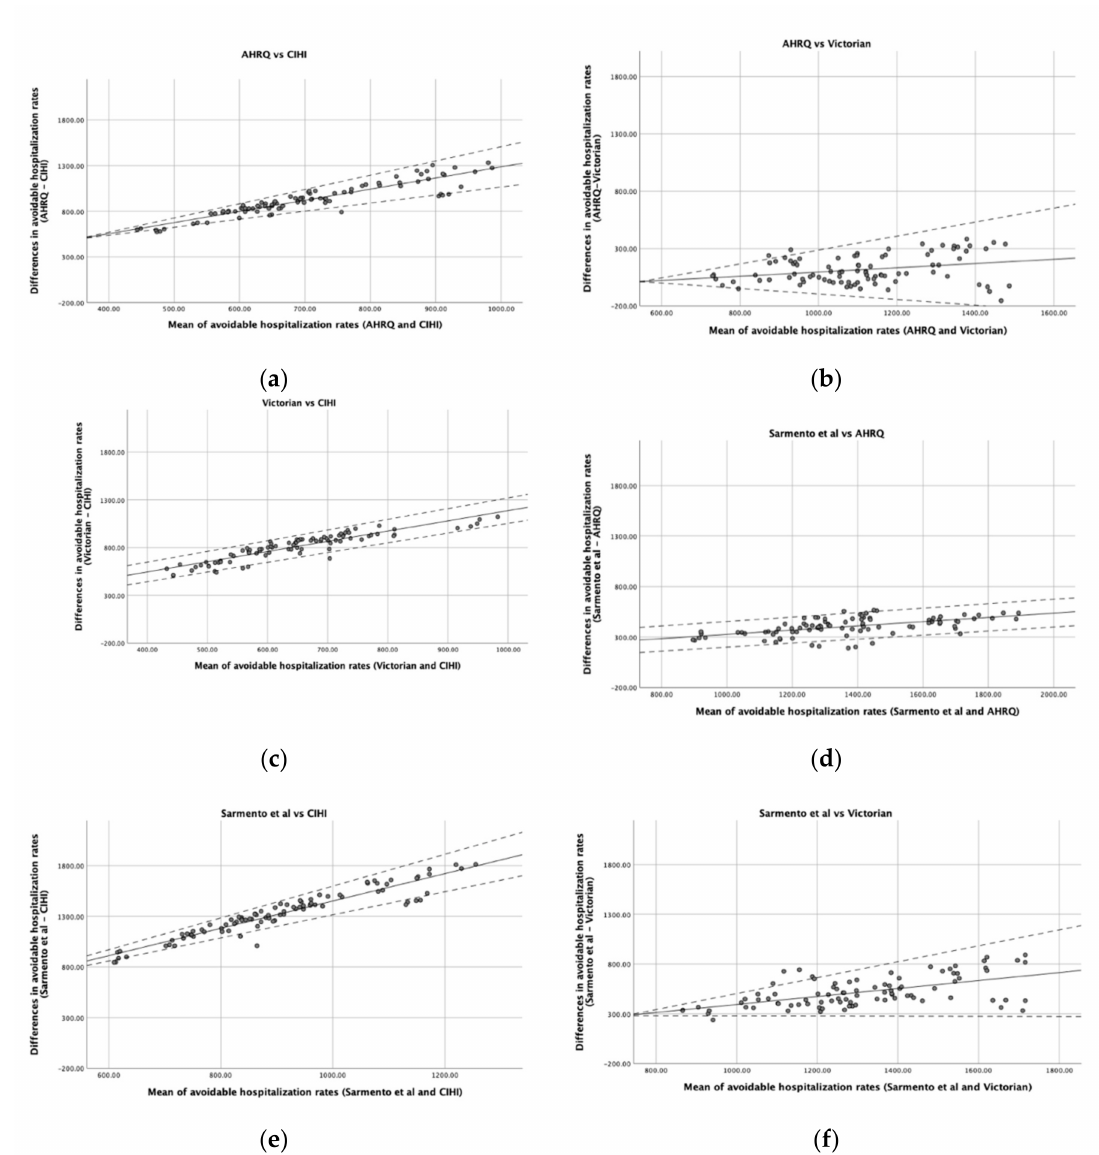
Figure 1. Bland and Altman plots comparing the agreement of di ff erent lists. ( a ) AHRQ vs. CIHI; ( b ) AHRQ vs. Victorian; ( c ) Victorian vs. CIHI; ( d ) Sarmento et al. vs. AHRQ; ( e ) Sarmento et al. vs. CIHI; ( f ) Sarmento et al. vs. Victorian. Solid line represents the di ff erence in avoidable hospitalization rates between lists and dashed lines indicate the Bland and Altman limits of